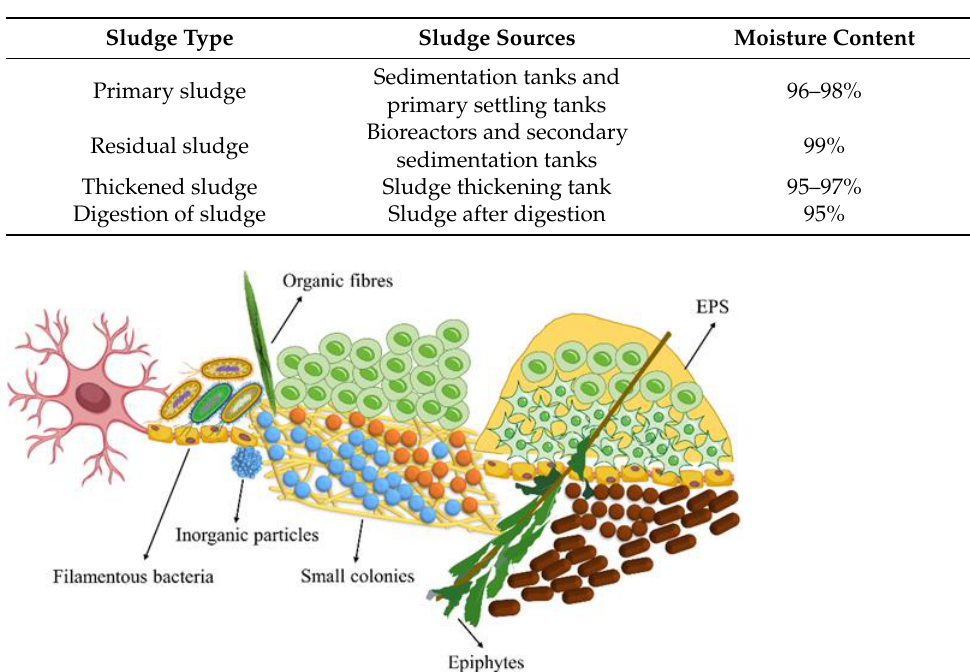
Figure 2. Schematic diagram of municipal sludge flocs.